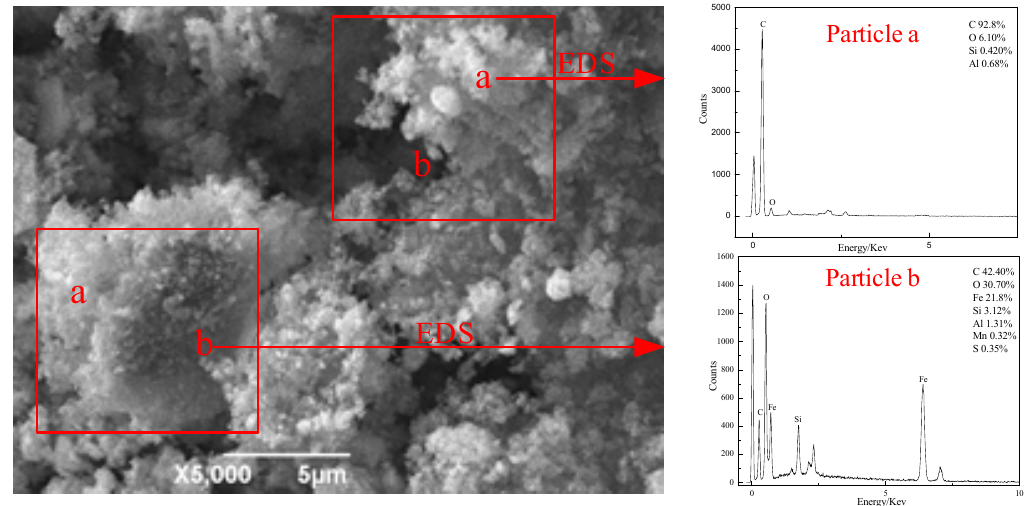
Figure 11. SEM diagram of the surface morphology of OMC fine iron ore particles after reduction by pure carbon monoxide at 1023 K, 0.8 m/s, 0.2 MPa.